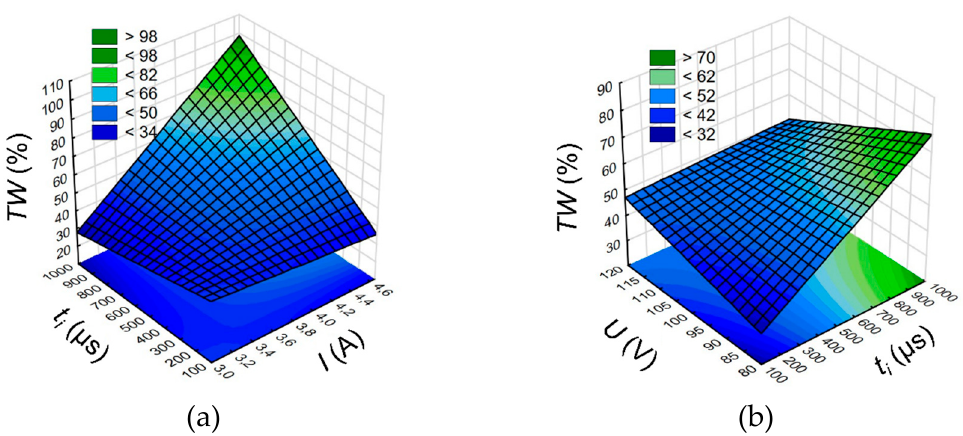
Figure 5. (a) Relationship between the linear tool wear TW and the pulse time t i and current amplitude I , U = 100 V and (b) discharge voltage amplitude U , I = 3.83 A.